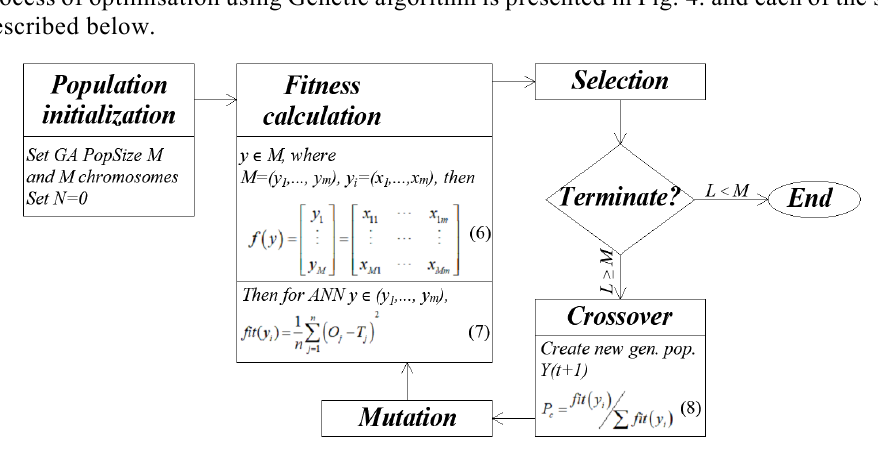
Fig. 4. Process of optimisation based on GA